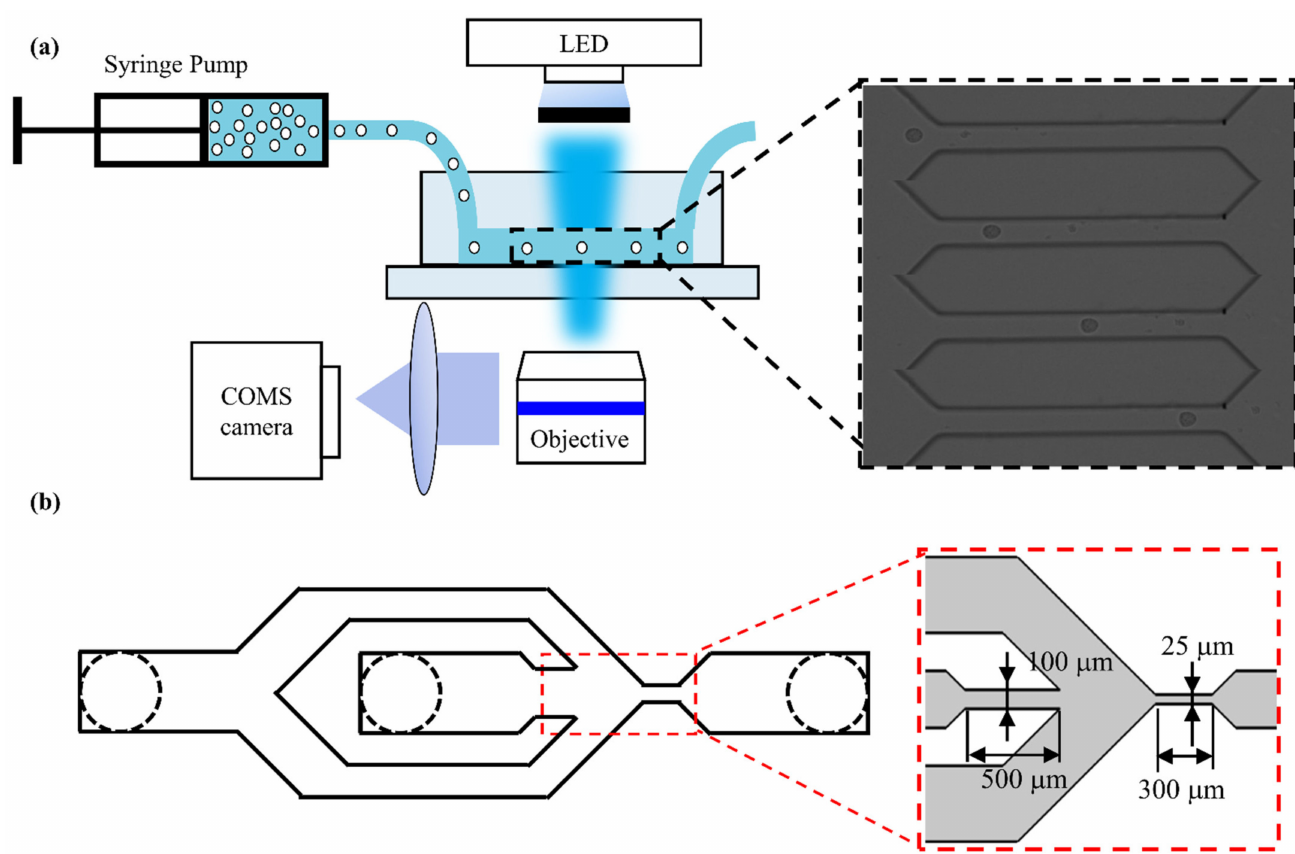
Figure 1. ( a ) The overview of the experimental system device and its detailed work schematic diagram and microfluidic channel geometry. The inset shows that cells flow through the constriction channel. ( b ) The improved microfluidic chip structure. The insets show the microchannel structure of the microfluidic